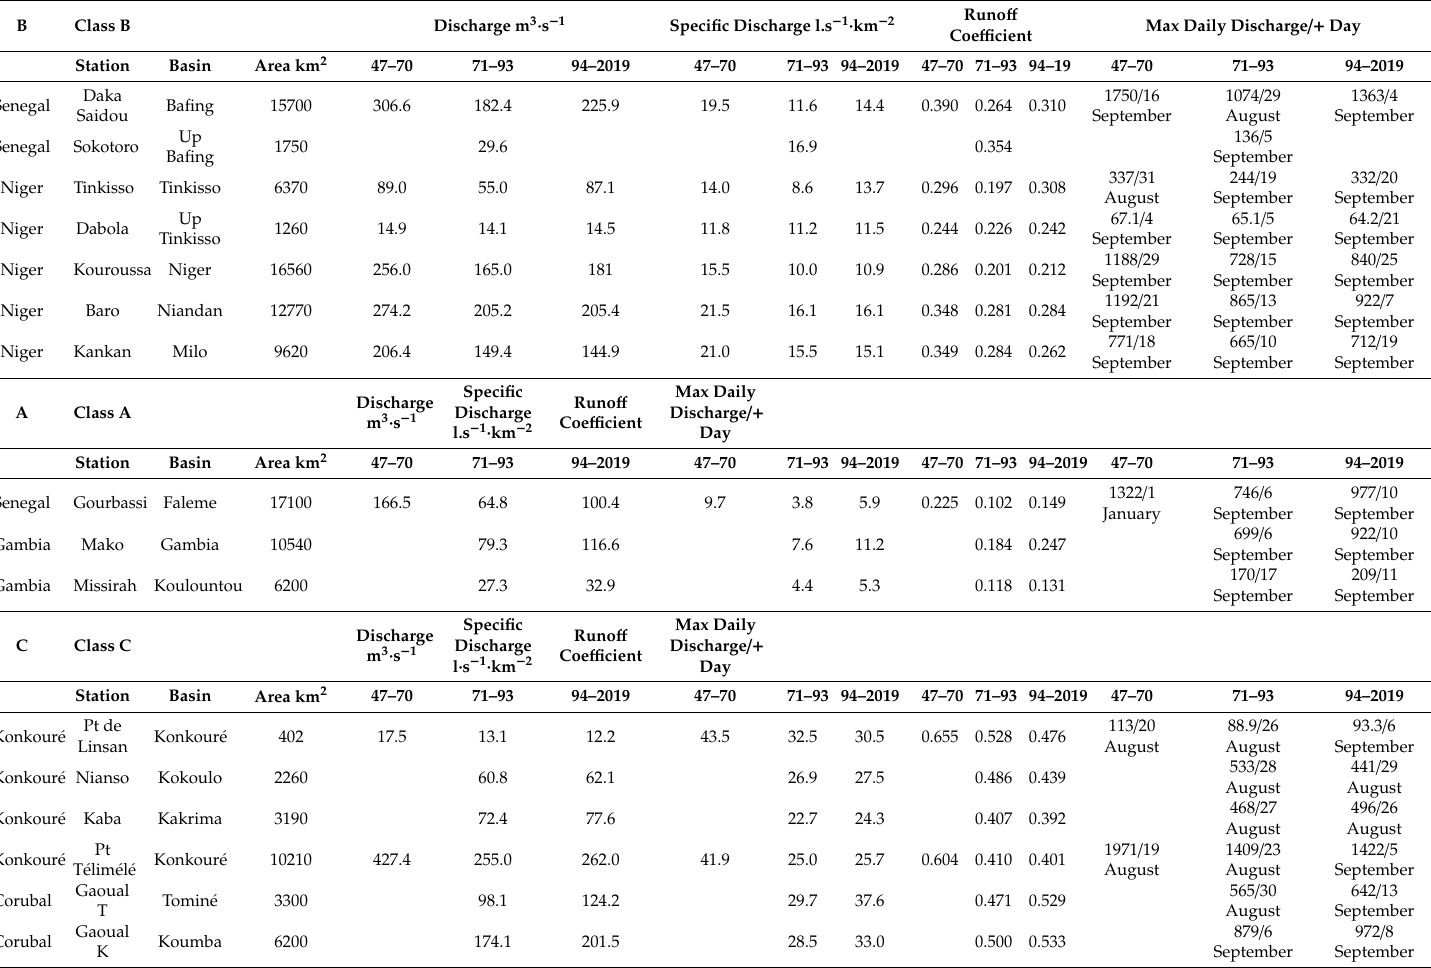
Table 3. Hydrological characteristics of the 16 classified